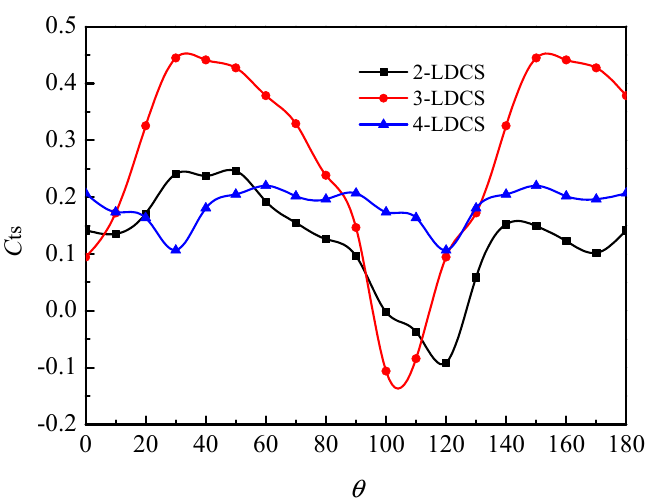
Figure 19. Curves of LDCS static torque coefficients of three numbers of blades with azimuth angle ( U = 6 m/s).